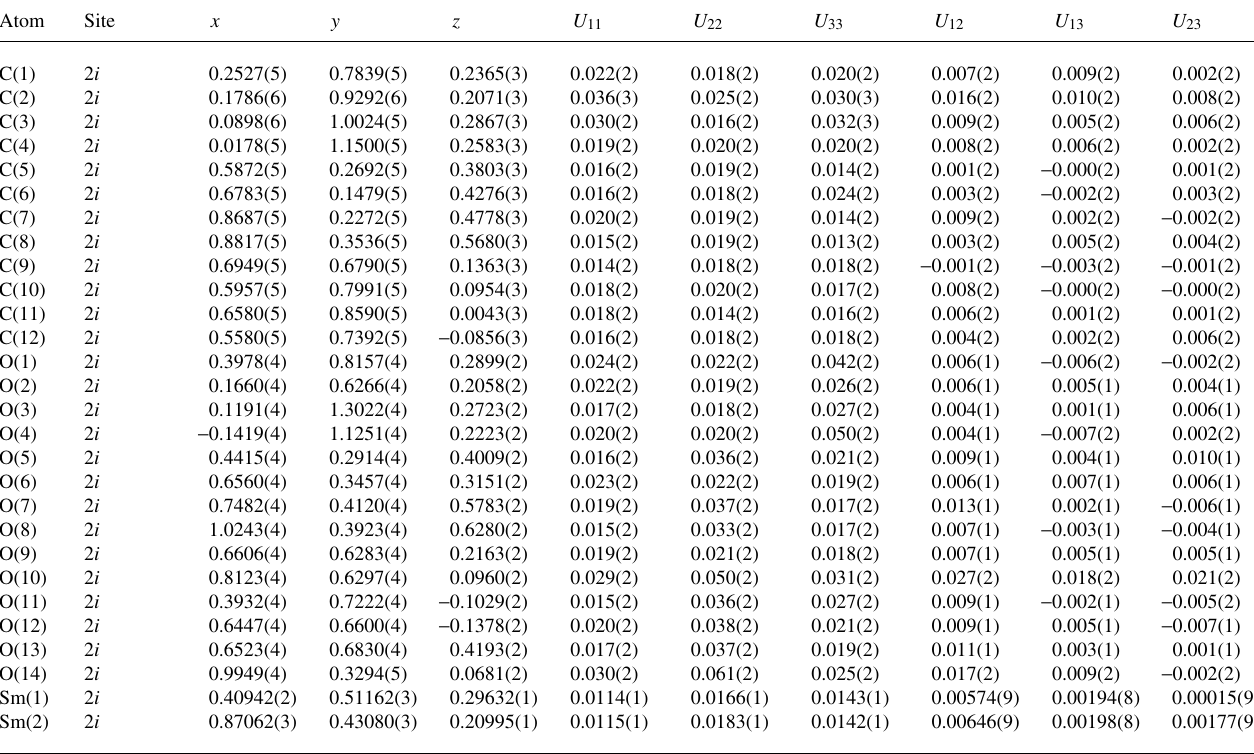
Table 3. Atomic coordinates and displacement parameters (in Å 2 )